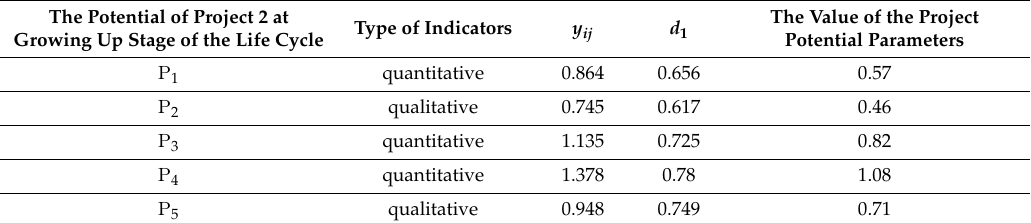
Table 11. Determination of Project 2 potential at the life cycle